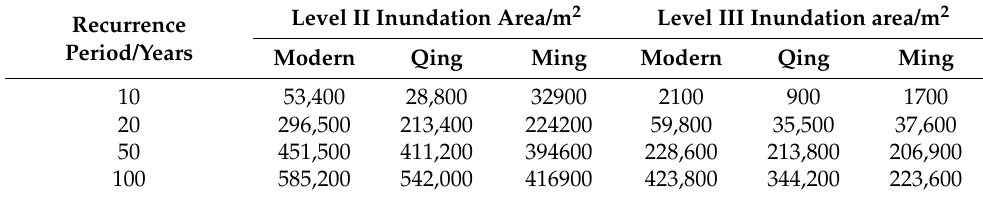
Table 7. Inundation area at level II and level III.